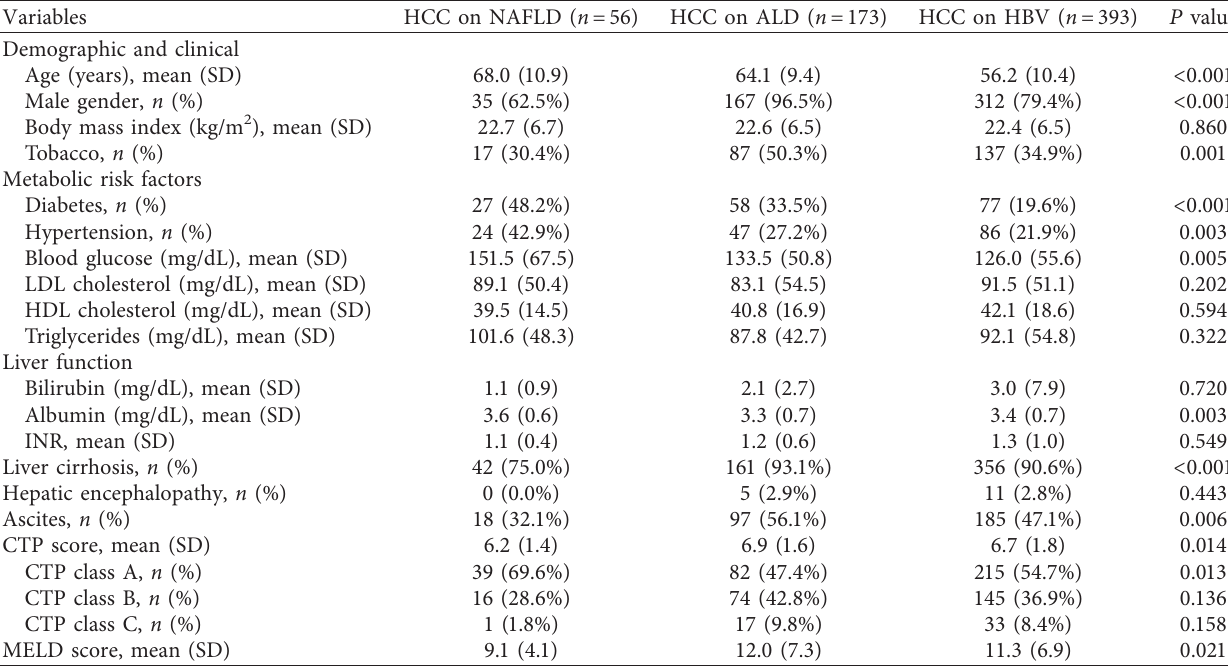
Figure 1: Schematic diagram of the study design and patients enrollment. HCC: hepatocellular carcinoma; ALD: alcoholic liver disease; HBV: hepatitis B virus; NAFLD: nonalcoholic fatty liver disease; HCV: hepatitis C virus. Table 1: Baseline demographic and clinical characteristics of